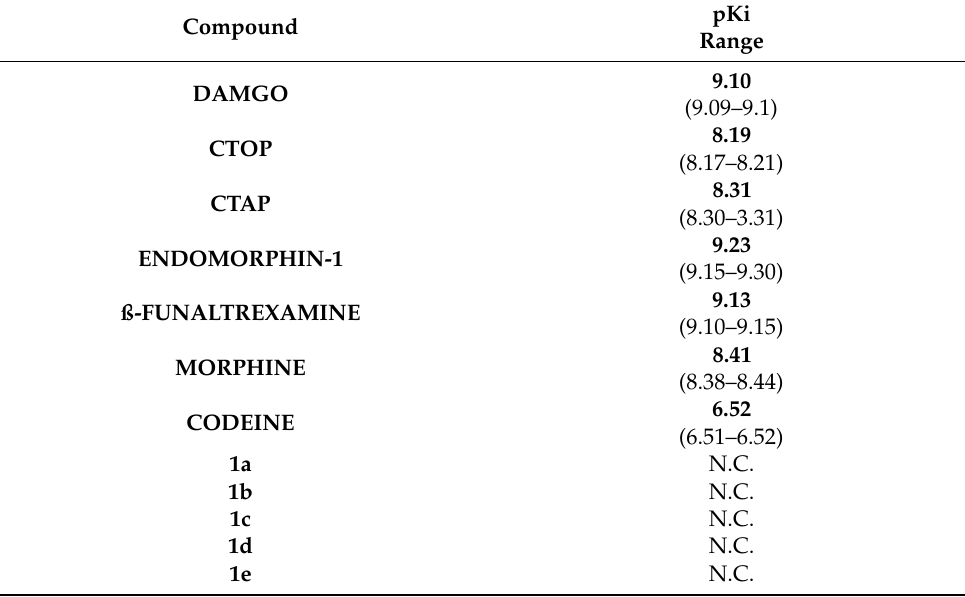
Table 1. Results of the binding of the references and tested compounds to the